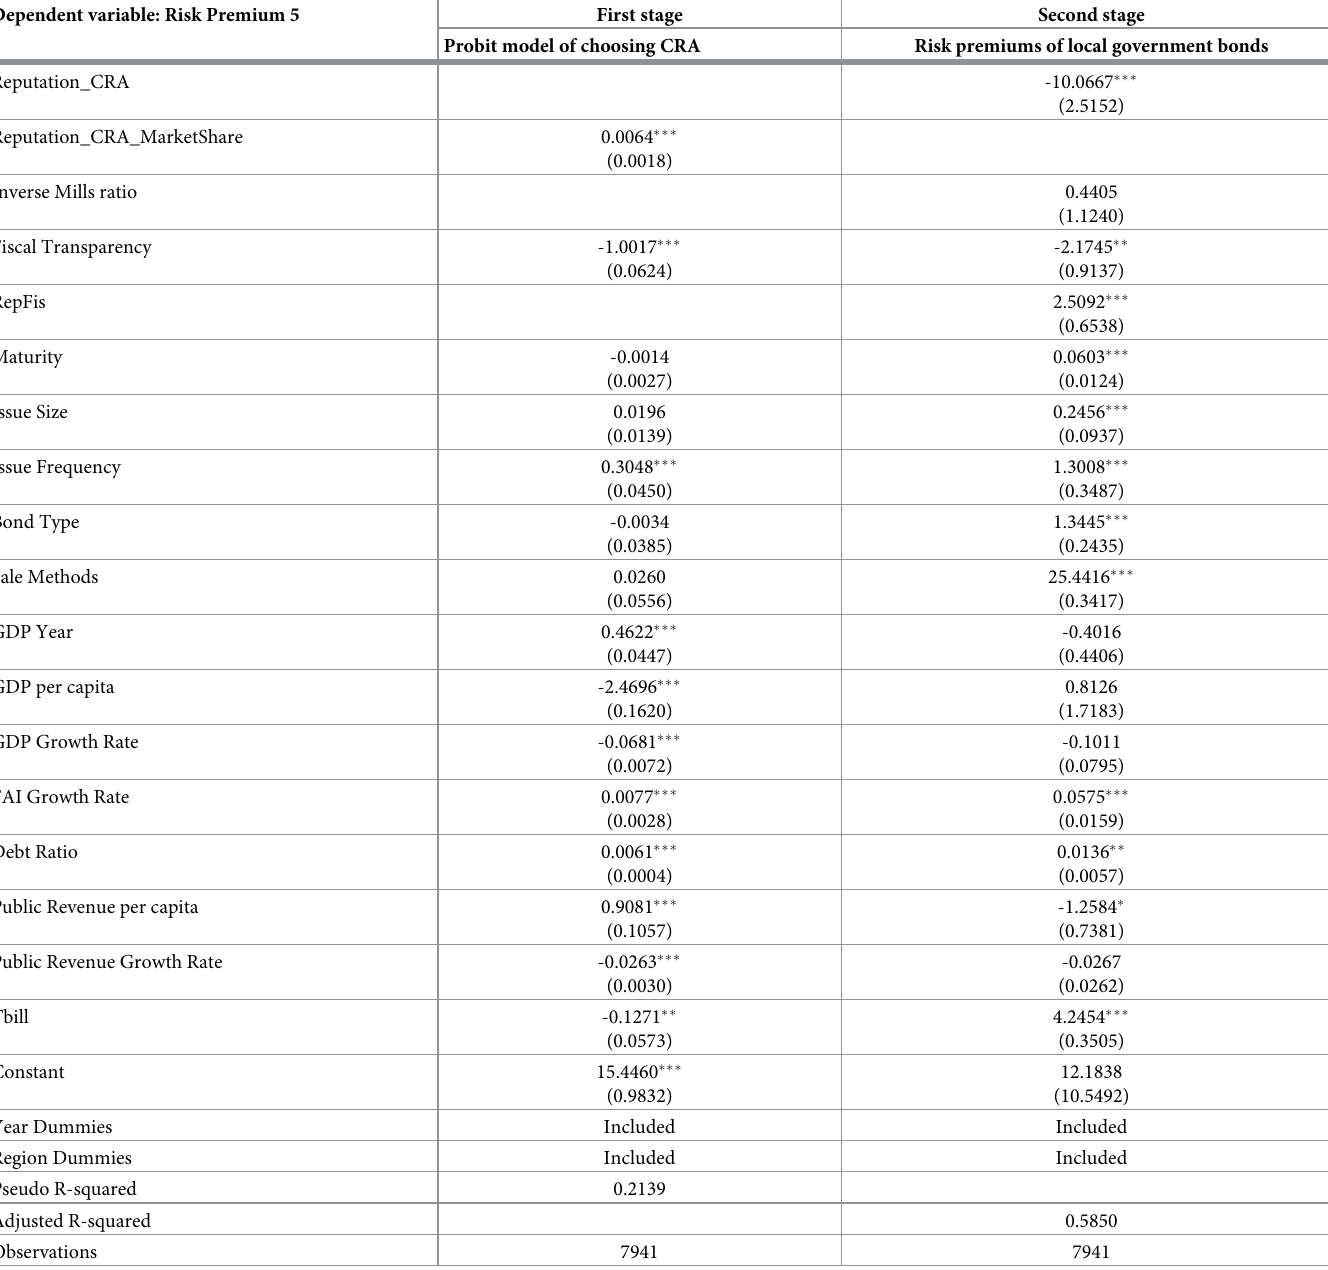
Table 9. Regression of risk premiums with Heckman correction. This table reports the estimates of Heckman two-stage model to control for potential sample selection bias. The first stage reports the results of probit model, while the second stage shows the results of the baseline regression